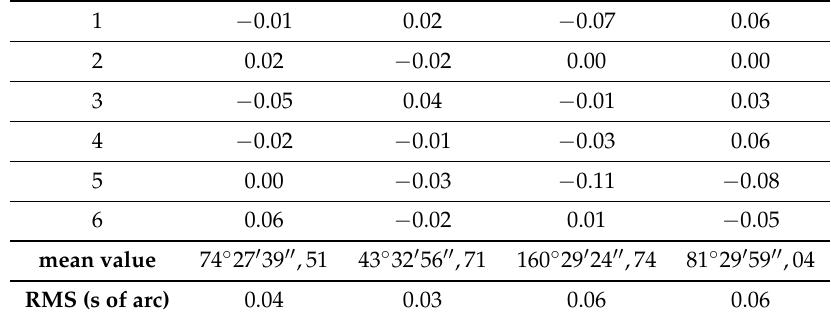
Table 2. Deviation from the mean in units of seconds of